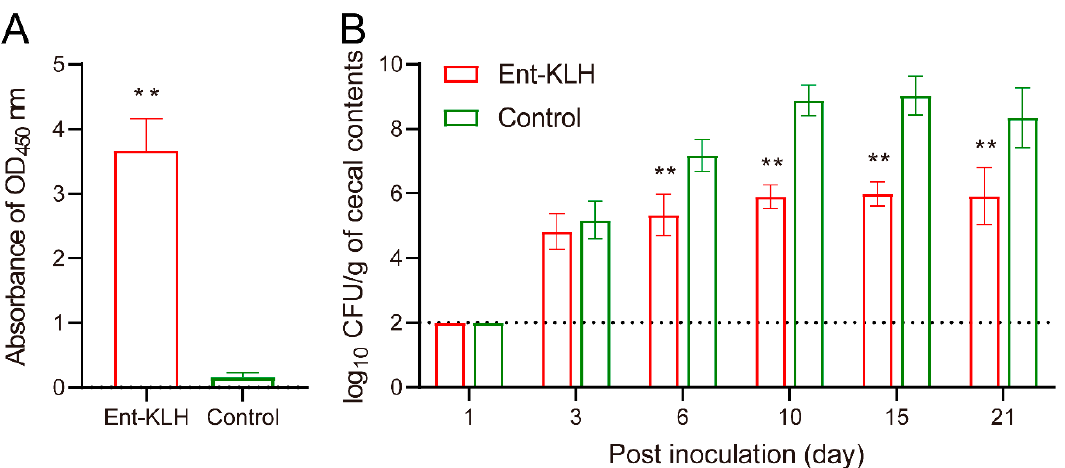
Figure 4. Enterobactin-specific immune response and protective efficacy of the Ent–KLH conjugate vaccine to mitigate C. jejuni colonization in chickens (Trial B with two immunizations). ( A ) The Ent-specific IgG in the chickens immunized with Ent–KLH or PBS. Each bar represents the average of OD 450 absorbance from 30 individual serum samples (200-fold dilution) with standard deviation indicated by error bar. ( B ) Comparison of colonization of C. jejuni NCTC 11168 in the chickens immunized with Ent–KLH or PBS. Each bar represents mean CFU / g cecal contents ± the standard deviation in each group. The dotted line indicates detection limit. ** p < 0.01.